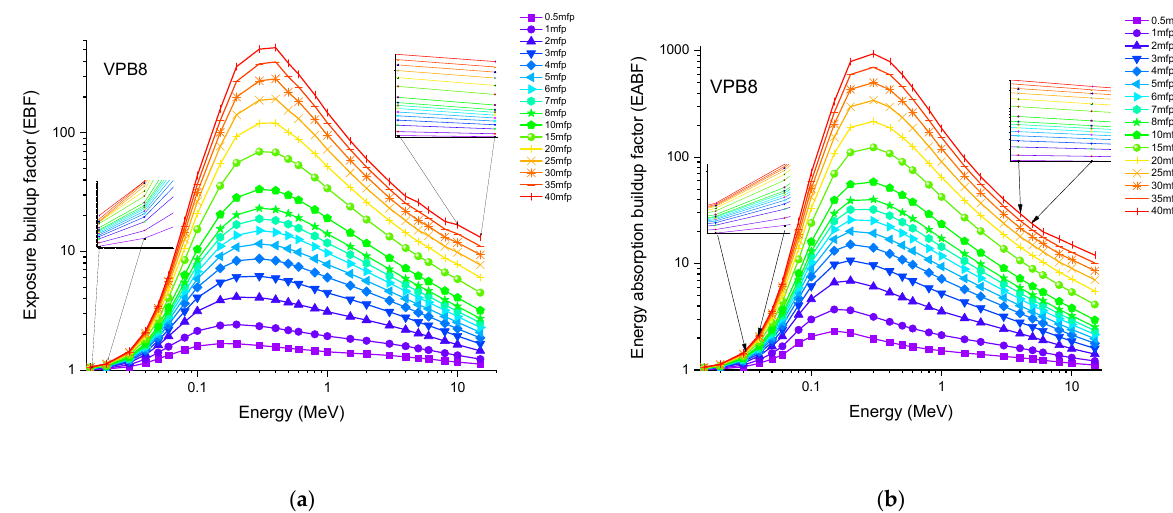
Figure 11. Variation of ( a ) EBF and ( b ) EABF against photon energy for sample VPB8.